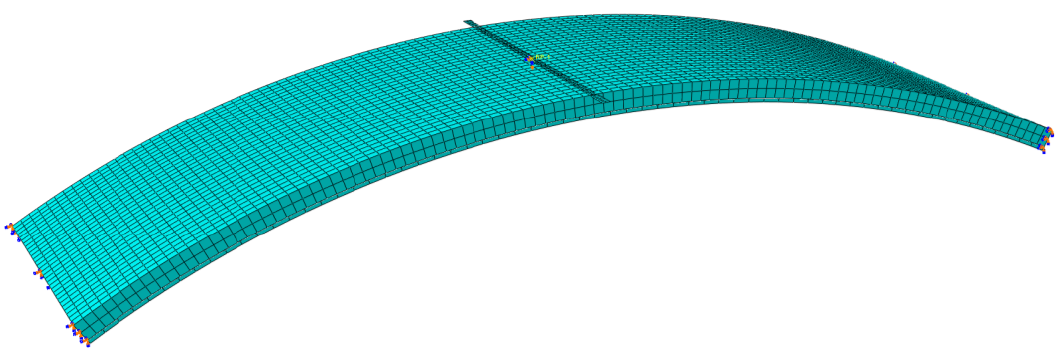
Figure 13. Boundary condition and loading for thin-shell structure.